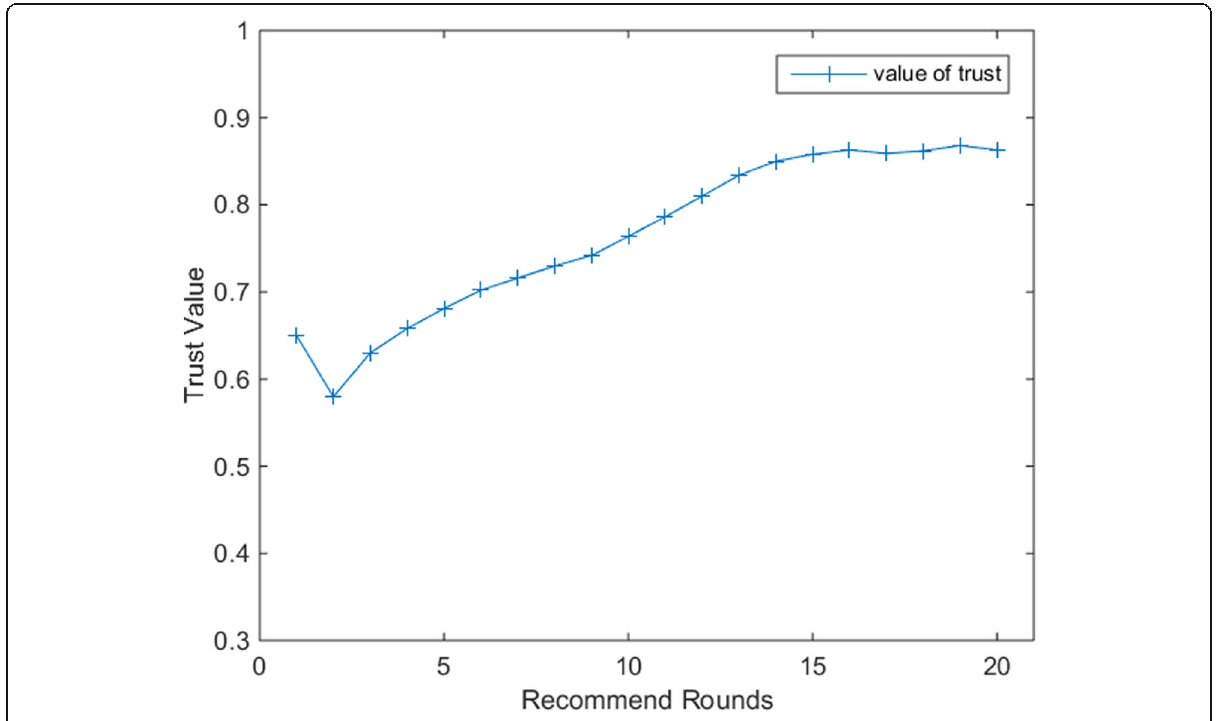
Fig. 11 The line chart of dynamic change of trust